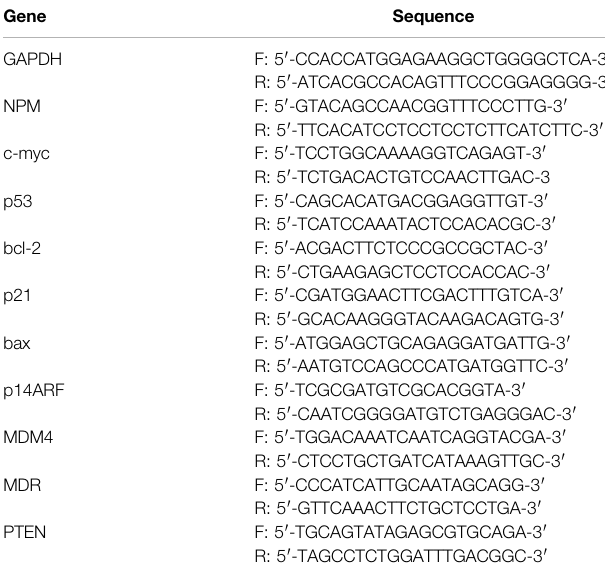
TABLE 1 | The primer sequences for qRT-PCR Gene Sequence